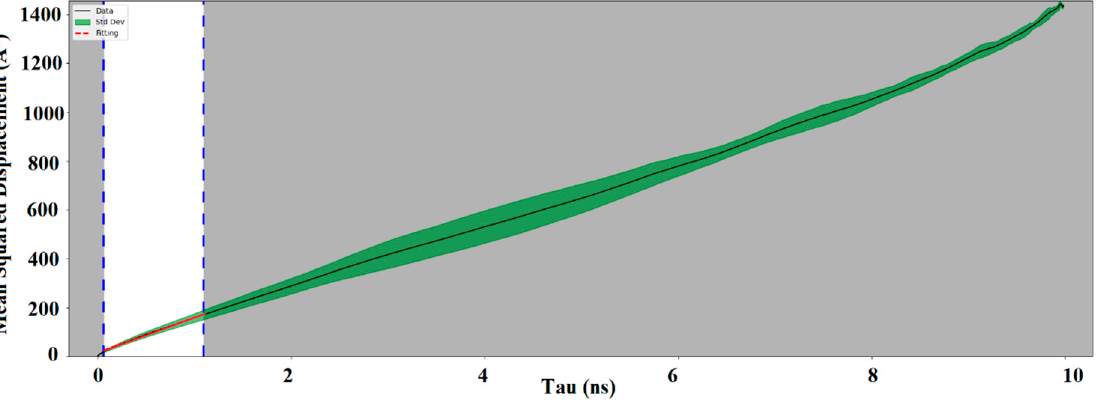
Figure 5. MSD curve obtained for adulose with oxygen molecules (black solid line is the data, green region is the standard deviation, and the red line is the fitting).